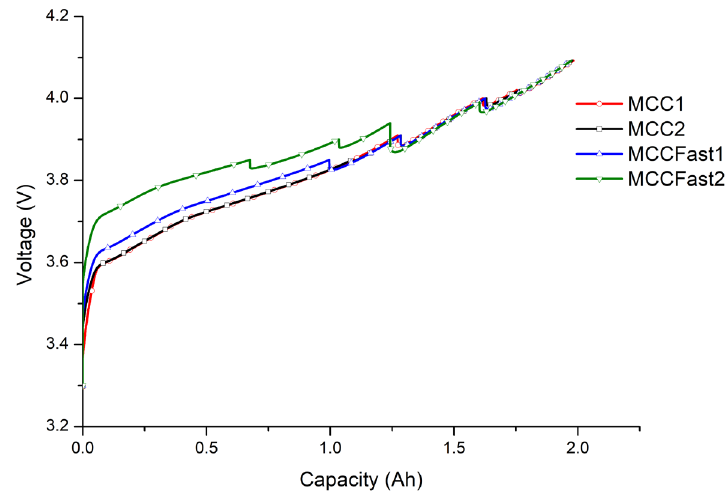
Figure 7. Voltage as a function of charged capacity for the MCC developed profiles.